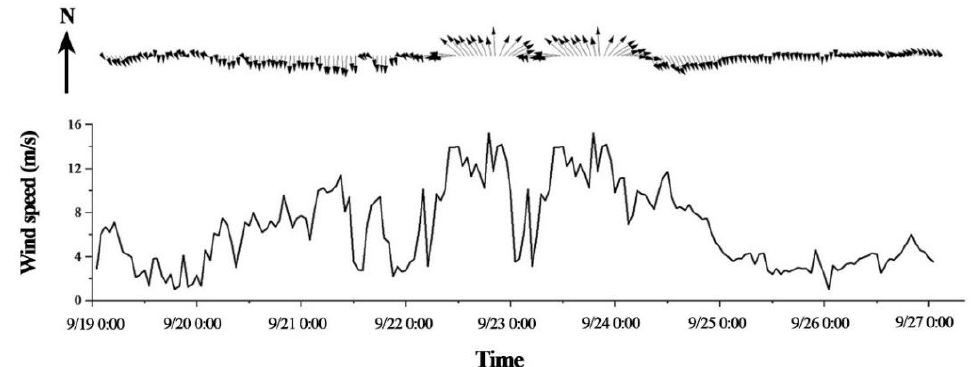
Figure 3. Wind process demonstrating the manifestation of Typhoon Fongwong at Sheshan station from 19 to 27 September 2014. The upper vectors are the wind speed and direction change phenom- enon.